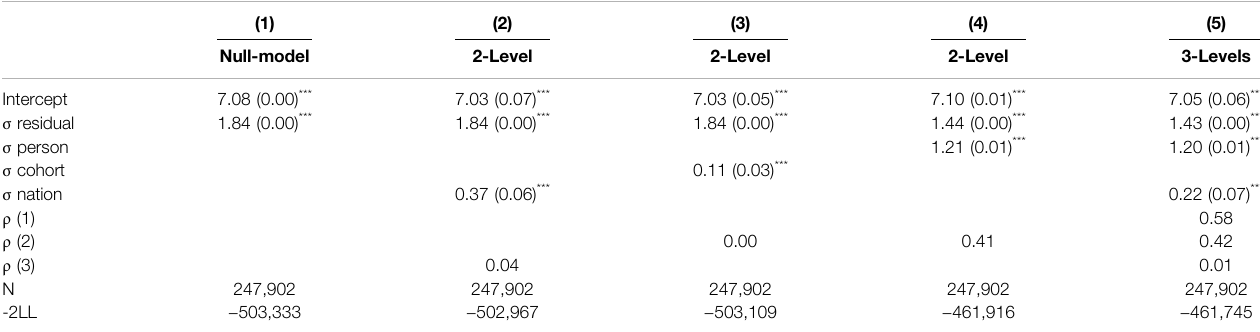
TABLE A1 | The multilevel structure of subjective well-being of migrants and